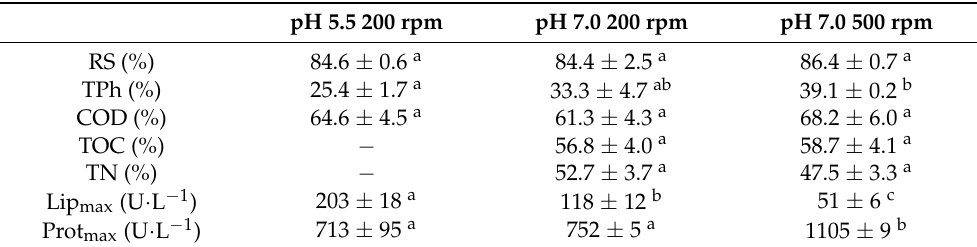
Figure 4. Time course of cellular growth ( a ), reducing sugars (closed symbols), and the total phenols (open symbols) concentration ( b ) obtained in C. tropicalis batch cultures carried out in a lab-scale bioreactor at pH 5.5 and 200 rpm ( • , ), pH 7 and 200 rpm ( (cid:4) , (cid:3) ), and pH 7 and 500 rpm ( (cid:78) , ∆ ). The error bars represent the standard deviation of two (cid:35) independent replicates. Table 6. Values of consumption of the reducing sugars (RS), total phenols (TPh), chemical oxygen demand (COD), total organic carbon (TOC), total nitrogen (TN), and maximum activity of lipase (Lip max ) and protease (Prot max ) obtained in C. tropicalis ATCC 750 batch cultures carried out in a lab-scale bioreactor at pH 5.5 and 200 rpm, pH 7 and 200 rpm, and pH 7 and 500 rpm. Data are the average ± standard deviation of two independent replicates. Values followed by the same letter in each row do not present statistically significant differences ( p ≤